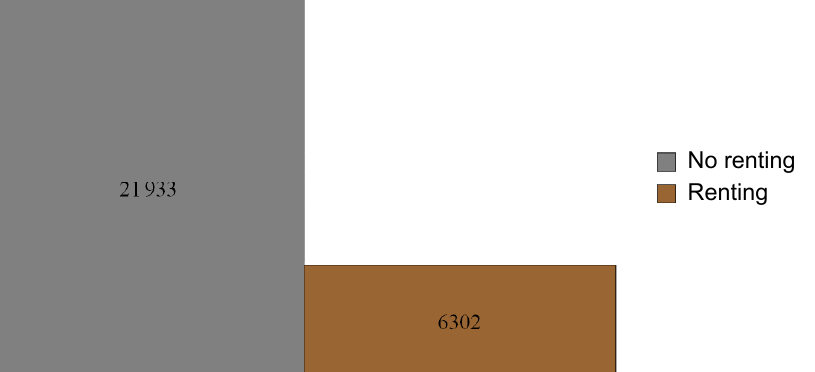
Figure 3. Histogram of the dependent